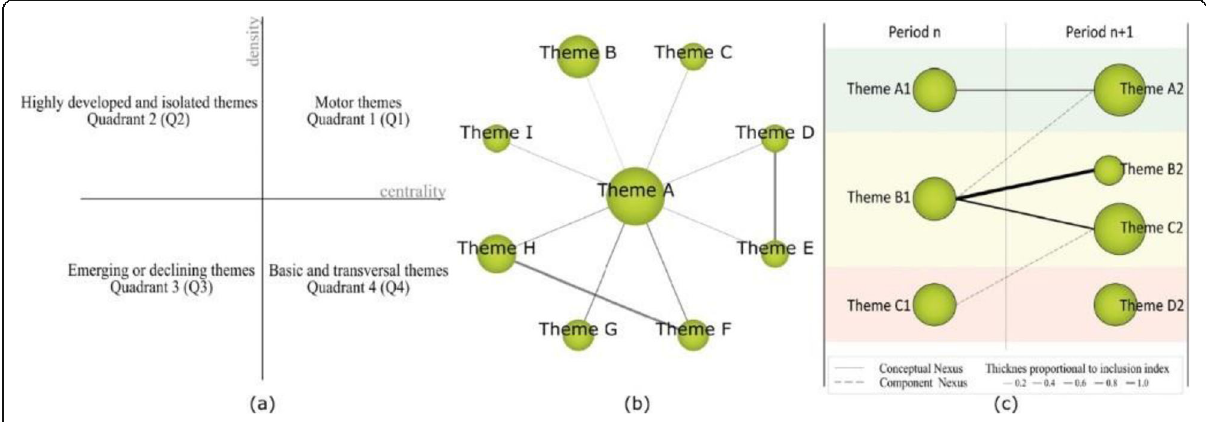
Fig. 2 Structure and data of co-word analysis with SciMAT. Note . Strategic diagram ( a ). Thematic network ( b ). Thematic evolution ( c )